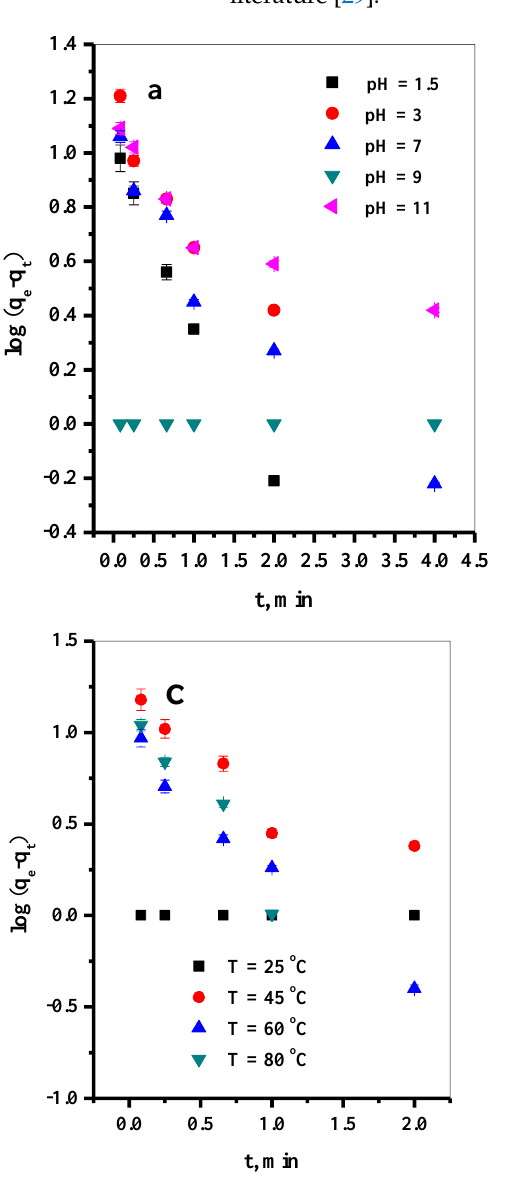
Figure 6. ( a ) Effect of contact time on removal percent of MB dye, ( b ) pH on the equilibrium constant, ( c ) pseudo-first-order plot, ( d ) pseudo-second-order plot (pH = 1.5–11, [MB] = 150 ppm, [P@SiO 2 ] = 25 mg/10 mL, T = 25 °C).